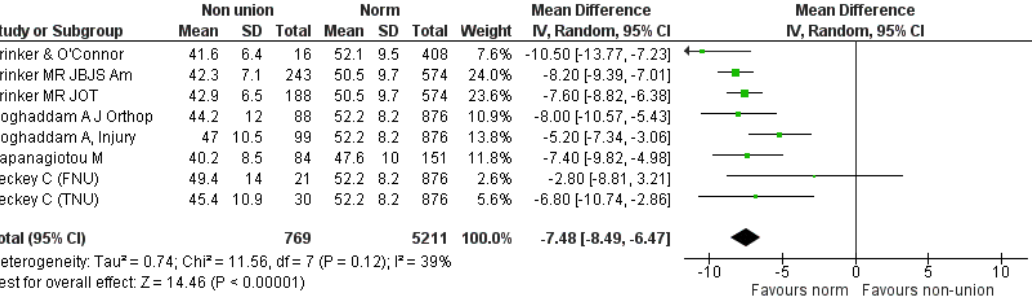
Figure 4. SF-12 MCS pooled analysis between non-union and respective normal population.